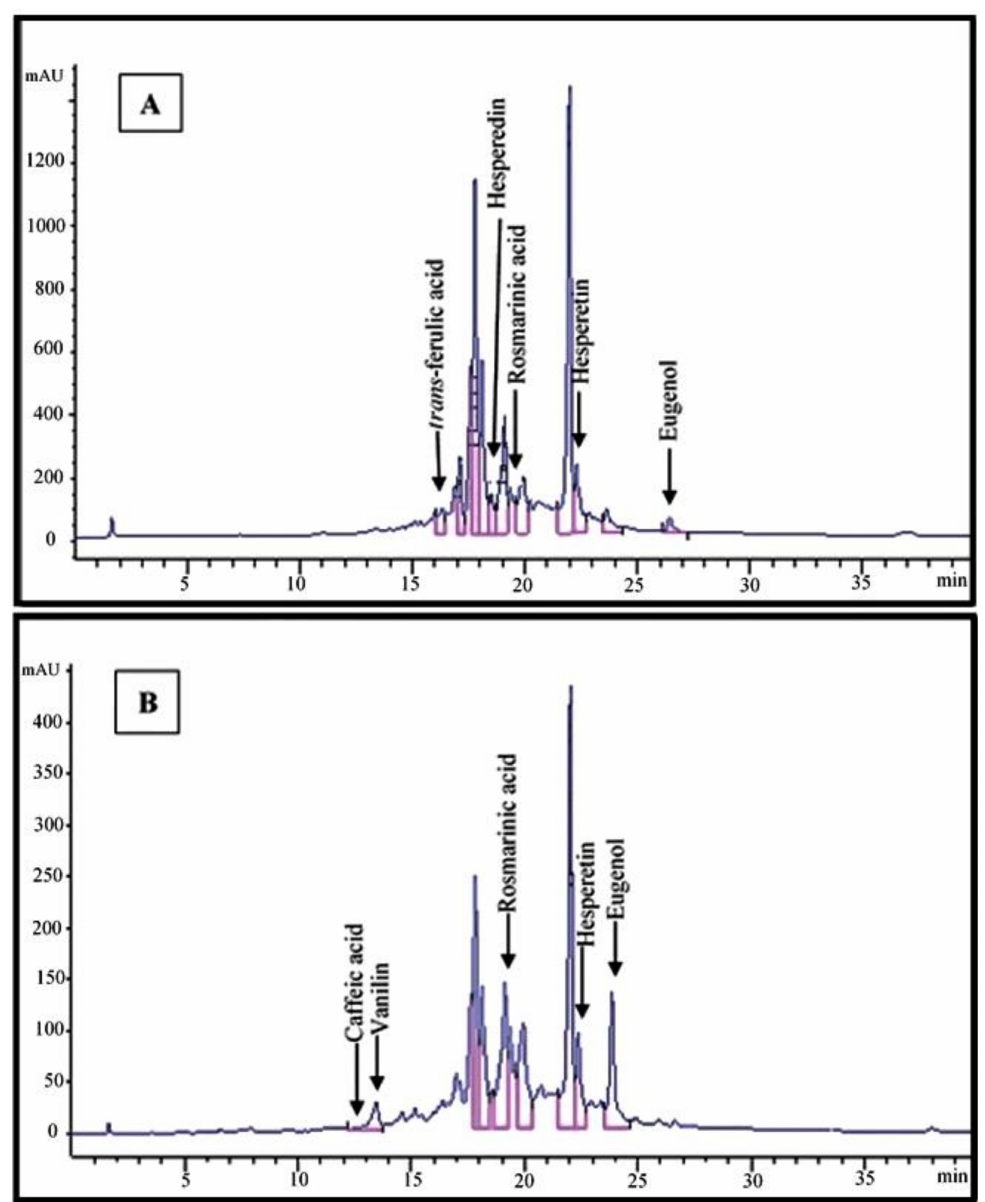
Figure 2. HPLC chromatograms of Pahleh extract ( A ) and Lizan extract ( B ) of Scrophularia striata . The presence of vanillin in eggplant root exudates is reportedly regarded as an in- hibitory effect and an obstacle to cropping [53]. It is known that vanillin has phytotoxic effects on goose grass ( Eleusine indica L.), particularly on its plantlet growth.